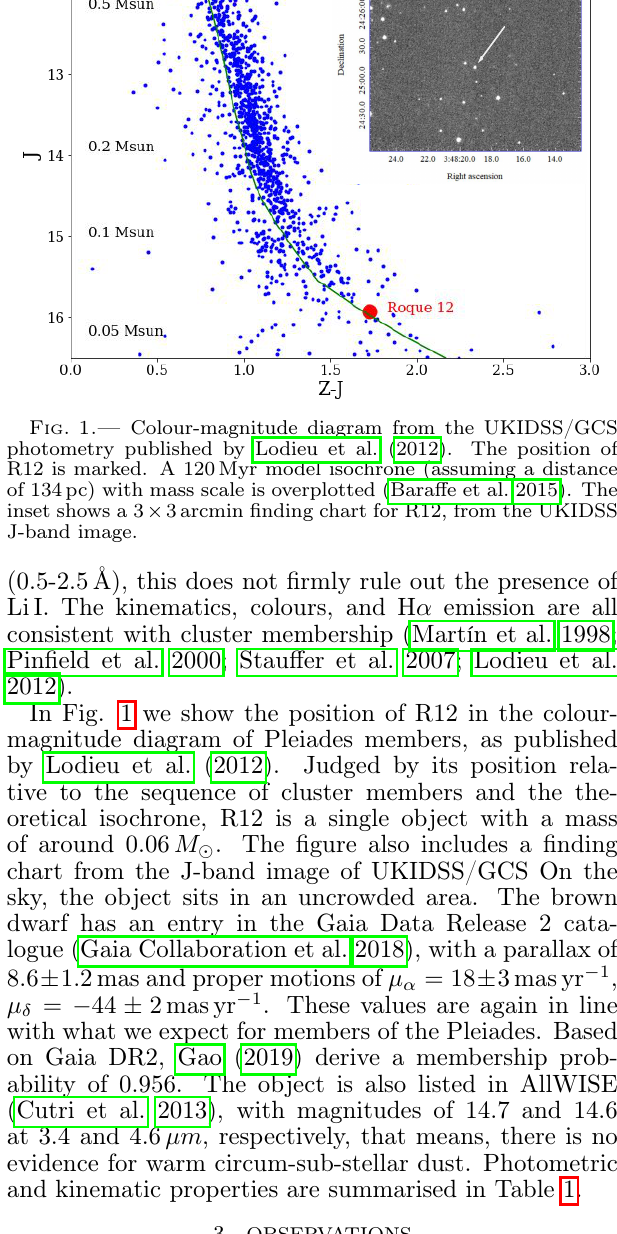
TABLE 1 Observational properties of Roque 12.